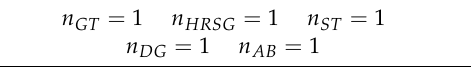
Table 5. Optimal synthesis of the system.